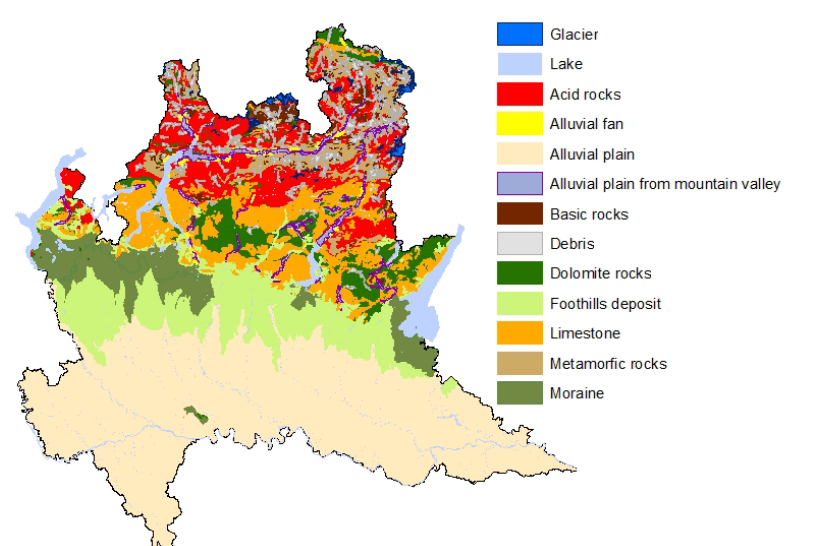
Figure 4. Geological types of Lombardy.